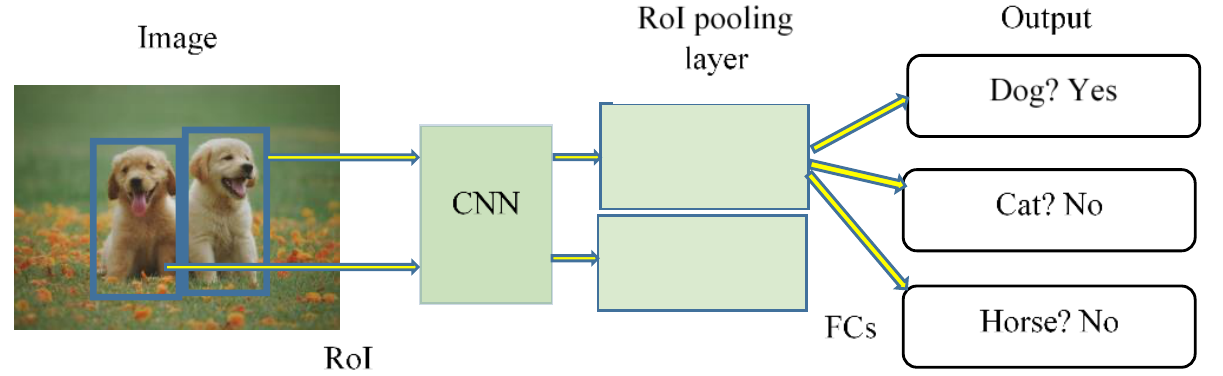
Figure 3. Fast R-CNN architecture where CNN is computed only for the proposed regions followed with similar FC layers classifying in the end. CNN is computed only for proposed regions followed by similar FC layers classifying in the end.